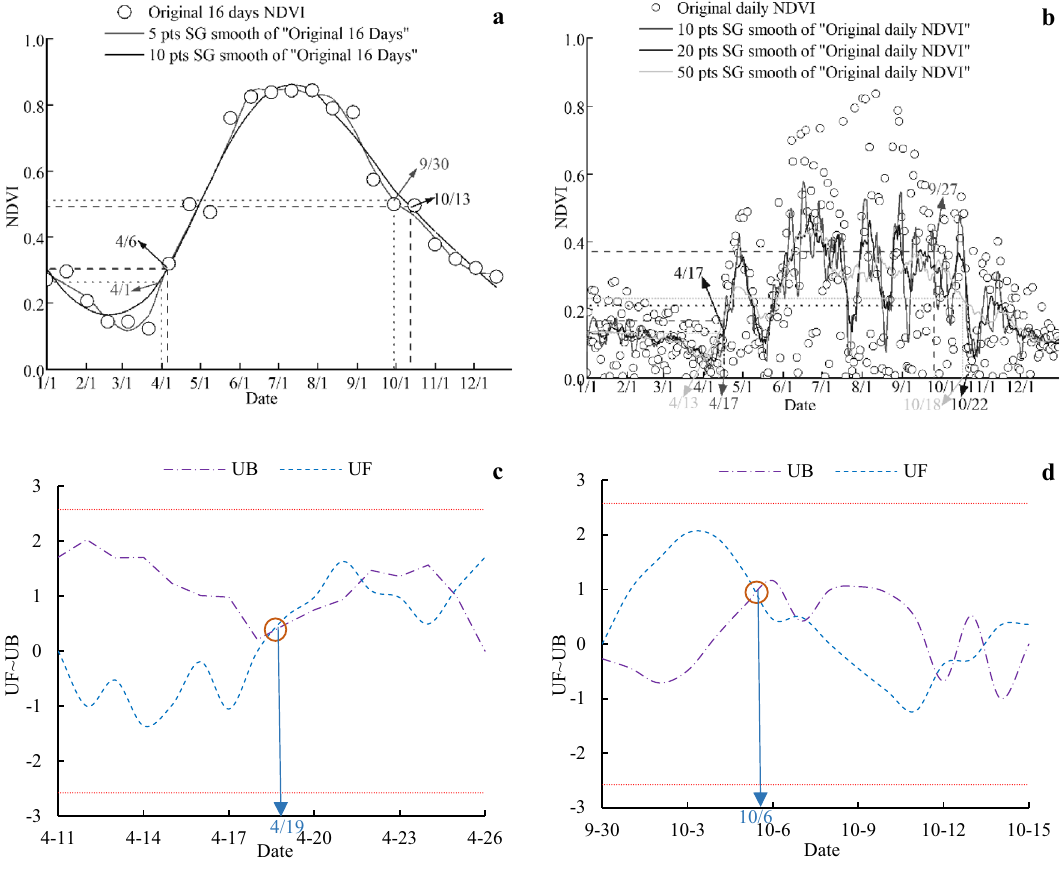
Figure 8. Comparison of RSP judgment between M-K and S-G smoothing methods (2019).